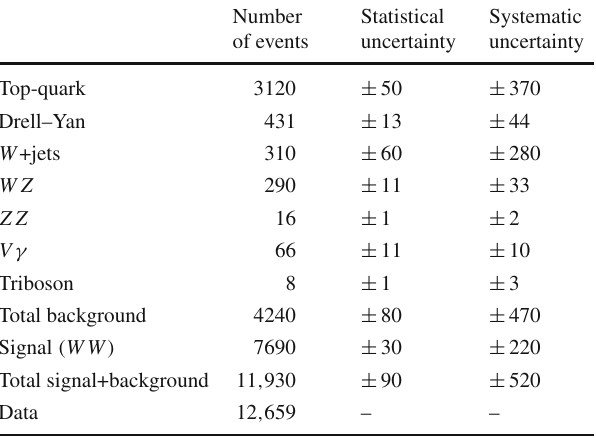
Table 2 Number of events observed in data, compared with the num- bers of predicted signal and background events in the signal region. The systematic uncertainties, described in Sect. 7, do not include the uncertainty in the integrated luminosity. The uncertainties in the